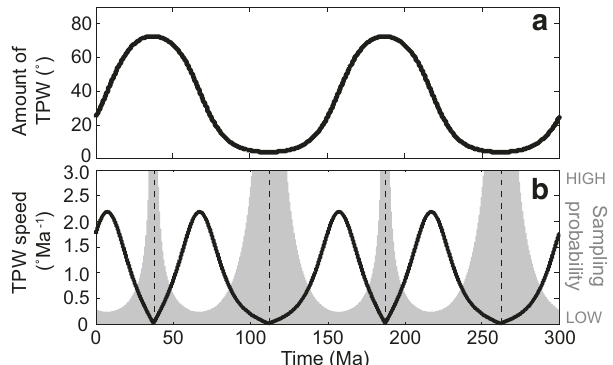
Fig. 4 | Probability of sampling true polar wander. a True polar wander (TPW) angleasafunctionoftimewithaninitialconditionof25°. b TPWspeed(blackline) and probability function (shaded gray) as a function of